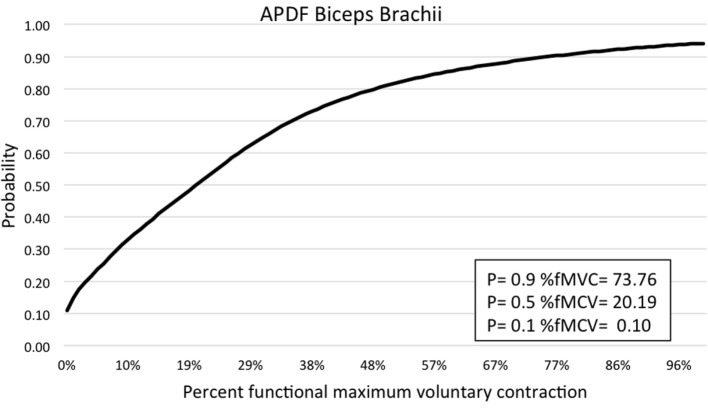
Graphic representation of typical APDF of the biceps brachii.